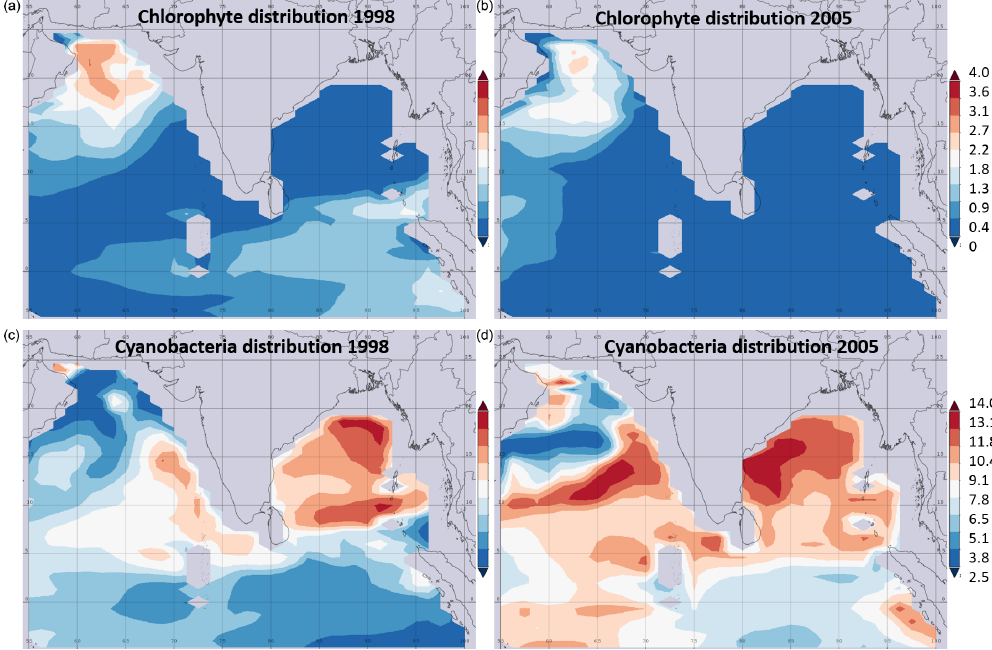
Figure 3. Satellite-imaging-based comparison of chlorophytes (a, b) and cyanobacteria from 1998 and 2015 in mgm − 3 . Data obtained from a combination of the Sea-viewing Wide Field of view Sensor (SeaWiFS), the Moderate Resolution Imaging Spectroradiometer (MODIS- Aqua), and the Visible Infrared Imaging Radiometer Suite (VIIRS) satellite product as available from https://giovanni.gsfc.nasa.gov (last access: 12 January 2021) have been averaged from 1 January to 15 December 1998 and 2005. The combination of those sensors allows for covering a range of different wavelengths useful to identify different phytoplankton clades. The maps have been generated using the NASA Ocean Biogeochemical Model (NOBM; Gregg and Casey, 2007) using the most recent version of the NASA ocean color data product (R2014). NOBM is designed to represent open ocean areas (water depths >